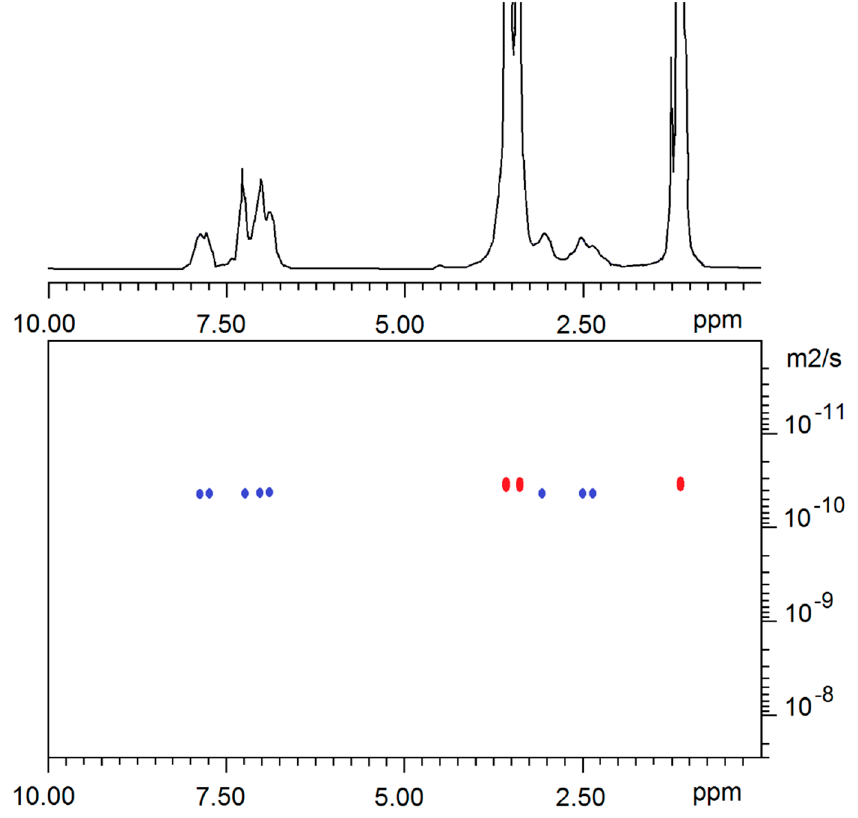
Figure 4. A 600 MHz 2D DOSY NMR spectrum of PPO- b -PEPK copolymer sample 2 (CDCl 3 , TMS scale, 25 °C) (Supplementary Materials). Table 2. The chem. shift of carbon numbers